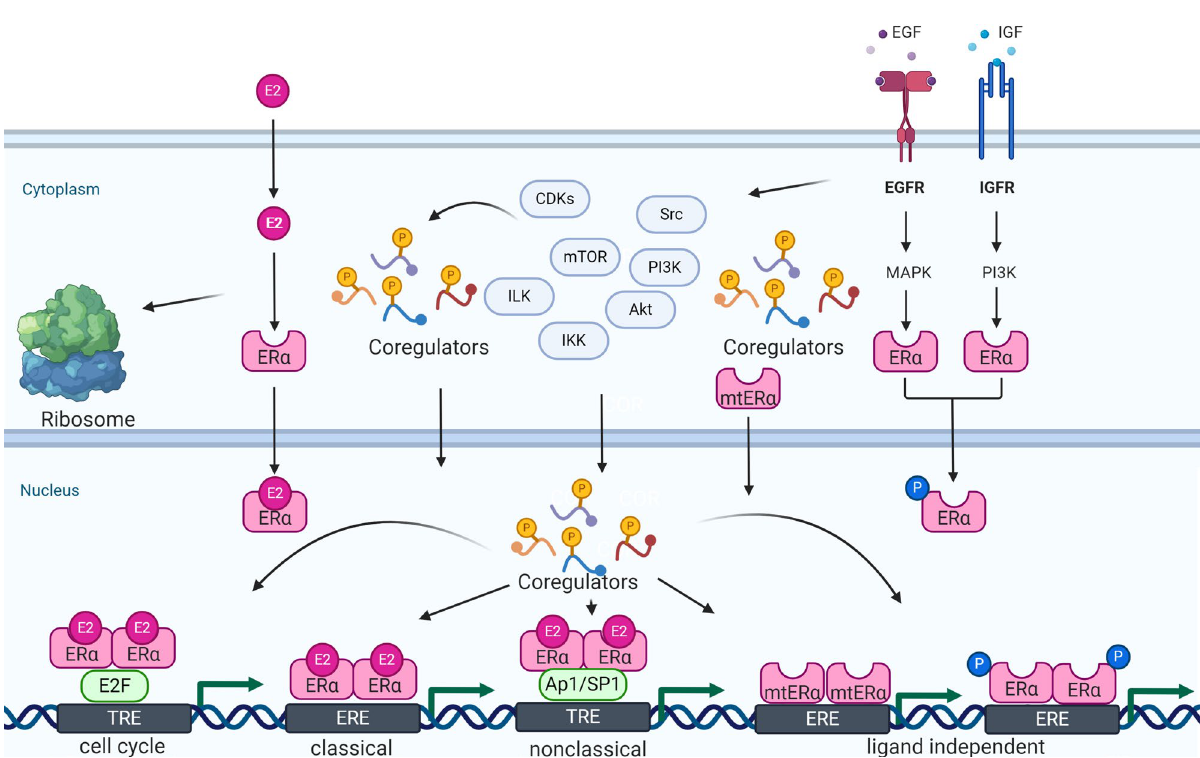
Figure 2. ER coregulator signaling mechanisms. ERα coregulators participate in multiple aspects of ER signaling including ER genomic (classical and non-classical), non-genomic, cell cycle, and ligand-independent signaling. In the cytoplasm, coregulators play a critical role in the activation of ER non-genomic signaling. Coregulators can be phosphorylated by cytosolic kinases and thus function as sensors of non-genomic signaling and integrate that signaling with ER genomic functions. Cell cyclin-dependent kinases (CDKs) also phosphorylate ER coregulators, and thus connect ER signaling to cell cycle progression. ER coregulators play an essential role in both classical and non-classical signaling via liganded ERα by promoting conducive chromatin remodeling. Deregulated growth factor signaling which commonly occurs in BC progression promotes post-translational modifications of ER and its coregulators; this facilitates ligand-independent activation of ERα target genes. Mutant ER (mtER) commonly occur in endocrine therapy resistant BC and mutations in the ligand binding domain of ERα create a constitutively active binding site for coregulators which promotes ligand-independent ER signaling. ILK: integrin-linked kinase; IKK: IkappaB kinase; mTOR: mechanistic target of rapamycin; EGF: epidermal growth factor; EGFR: EGF receptor; MAPK: mitogen-activated protein kinases; IGF: insulin-like growth factor; IGFR: IGF receptor; E2F: early 2 factor; TRE: trehalose; mtERα: mtER